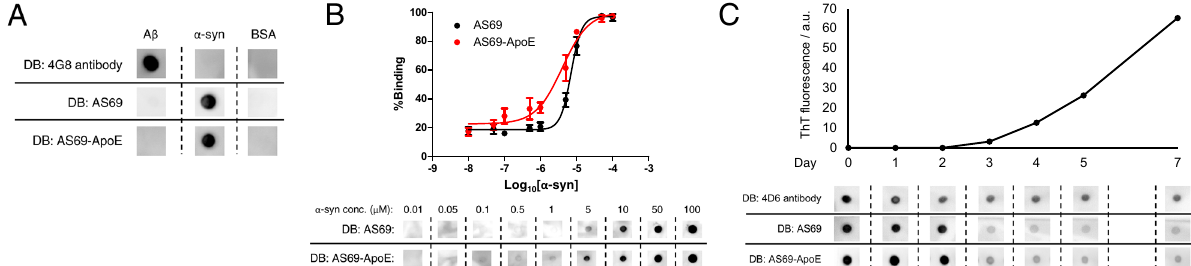
Figure 2. Binding properties of AS69 and AS69-ApoE evaluated by dot blot. (A) Binding affinity of AS69 and AS69-ApoE against amyloid-β 1–42 (Aβ 1-42 ) and α-synuclein monomers. Aβ 1-42 and α-synuclein monomers were blotted on a nitrocellulose membrane at a concentration of 100 µM. AS69 and AS69-ApoE were detected by anti-His-tag antibody. Bovine serum albumin (BSA) was used as a negative control. (B) Binding of AS69 and AS69-ApoE with different concentrations of α-synuclein monomers (10 nM–100 µM) (n = 5). The percentage of binding was calculated from grey values. (C) Binding characteristics against different conformations of α-synuclein. The α-synuclein monomers (280 µM) were incubated and sampled after 0, 1, 2, 3, 4, 5, and 7 days. The thioflavin T fluorescence assay was performed on each sample to monitor fibrilisation status. a.u., arbitrary (Fig. 1A, 22 kDa) with the aim of transporting the AS69 functional domain to the brain (Fig. 1B).The rigid helical linker reportedly increases protein stability and rigidly separates the two functional domains 27–29 . Although several methods for protein radiolabelling with fluorine-18 have been reported, the development of mild, site-specific, and robust radiolabelling methods has been challenging 13,16 . As an option to solve these issues, we have developed a cell-free protein radiosynthesis (CFPRS) system for protein fluorine-18 labelling with a genetic expansion strategy using p -cyanophenylalanine aminoacyl-tRNA synthetase ( p CNF-RS), tRNA optimised for amber codon recoding (tRNA CUA opt ), and O -2-[ 18 F]fluoroethyl-L-tyrosine ([ 18 F]FET). The CFPRS system enables site-specific fluorine-18 radiolabelling of various proteins with a high molar activity under mild conditions and with short reaction times through a simple addition of the template DNA 30 . In the biological translation process of the CFPRS system, the amber codon inserted after the start codon of the original sequence encodes the [ 18 F]FET, resulting in the facile radiolabelling of proteins (Fig. 1C,D). Using this CFPRS system, we successfully labelled an affibody molecule that binds to human epidermal growth factor receptor type 2 with fluorine-18 and demonstrated the utility of the construct in tumour PET imaging 30 . In the present study, we determined the binding characteristics of AS69 and the newly designed AS69-ApoE construct in vitro and radiolabelled AS69 and AS69-ApoE with fluorine-18 (obtaining 18 F-AS69 and 18 F-AS69- ApoE) using the CFPRS system. We used 18 F-AS69 and 18 F-AS69-ApoE in wild-type mice to evaluate and com-